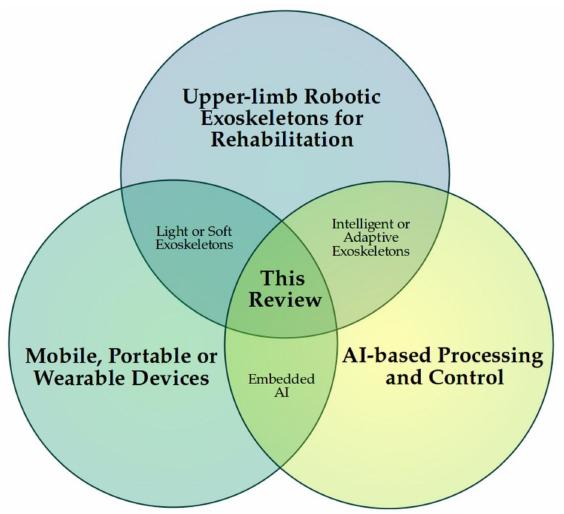
Figure 2. Graphic summary of the main axes that constitute this systematic